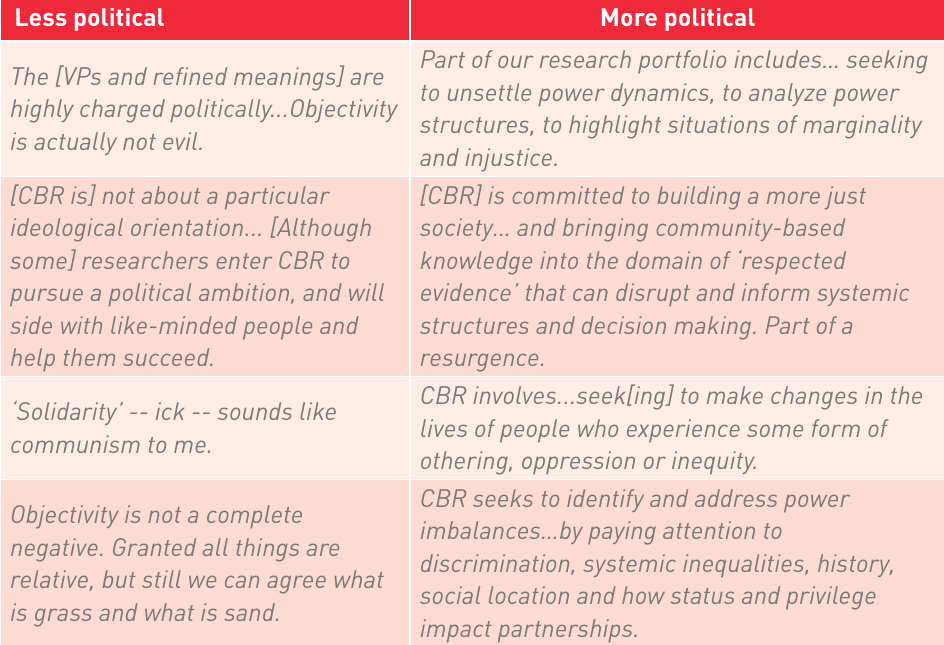
Divergent perspectives on the political nature of CBR Less political More political